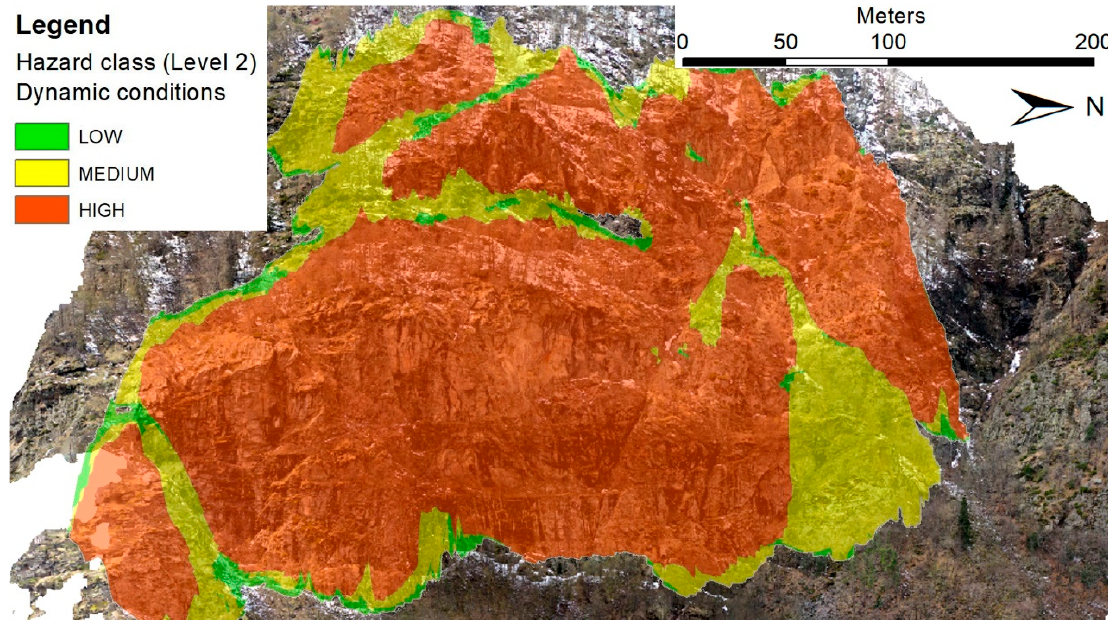
Figure 12. Frontal view of the Level 2 hazard map (seismic conditions).